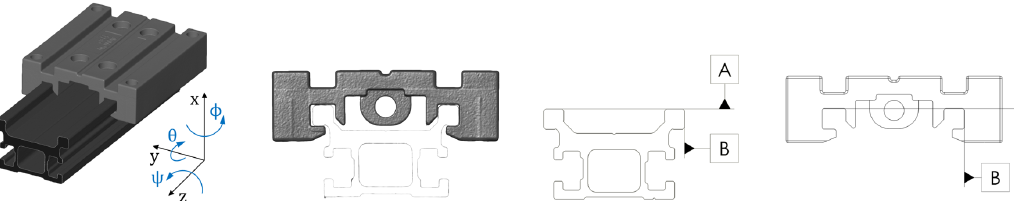
Figure 3. Shown, from left to right, is the 3D representation of the VA, the front view of the assembly, and a technical drawing of the datum system (primary datum A, secondary datum B, and tertiary datum constrained to zero t z = 0 and defined for both the rail and the